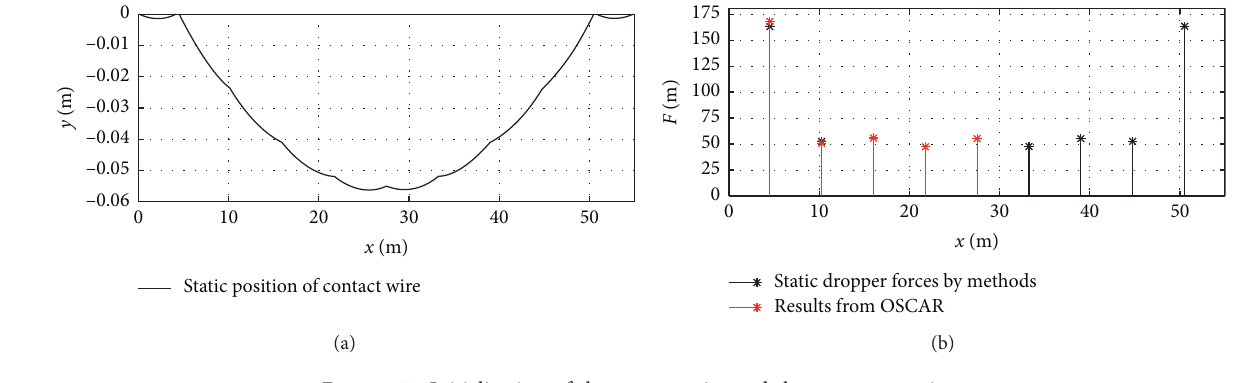
Figure 11: Initialization of the contact wire and the messenger wire.